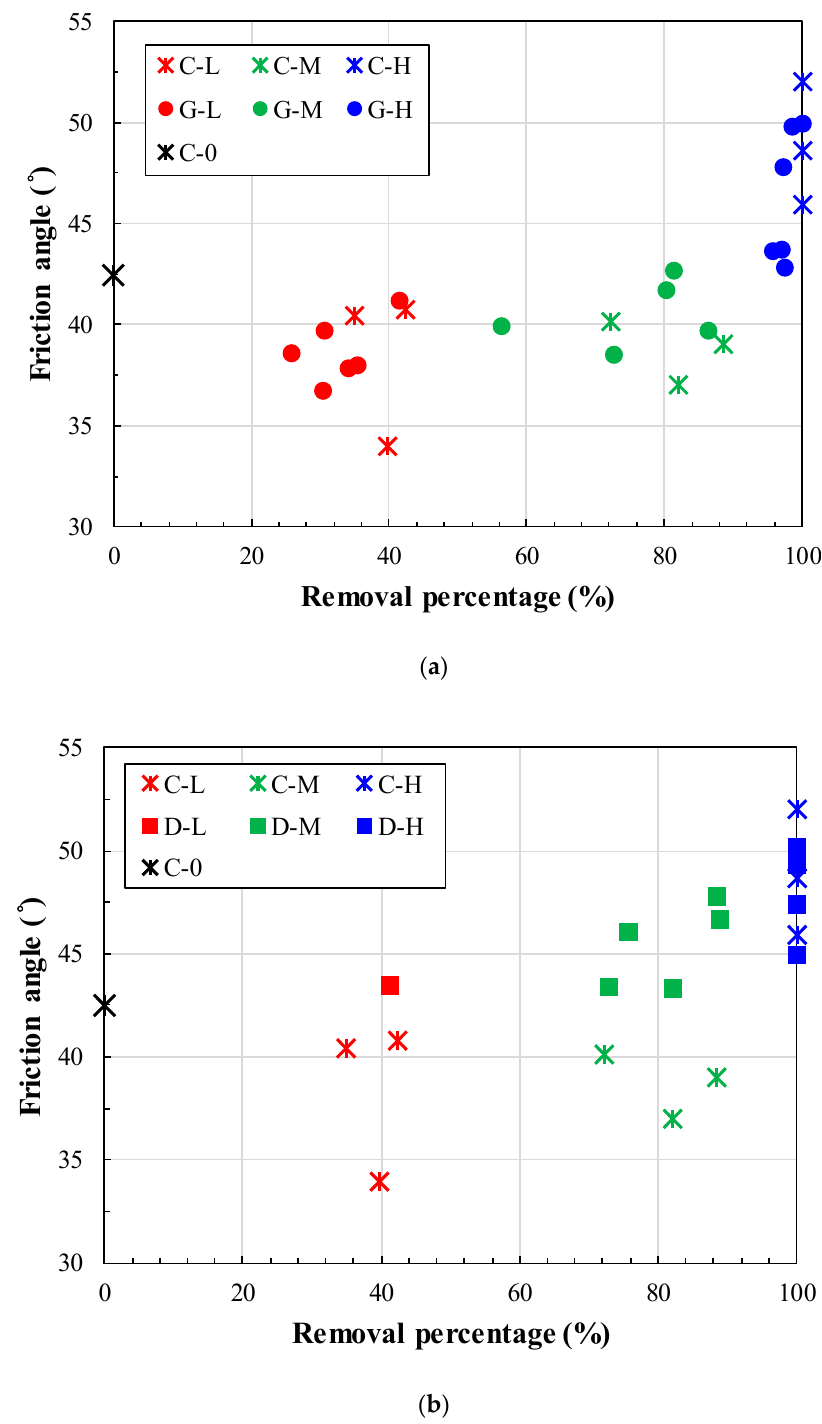
Figure 4. Relationship between pollutant removal percentage and frictional angle. ( a ) Gasoline; ( b ) Diesel. Note: C: original soil; G: soil with gasoline pollutant; D: soil with diesel pollutant. L: heating temperature is 320 °C; M: heating temperature is 560 °C; H: heating temperature is 900 °C.